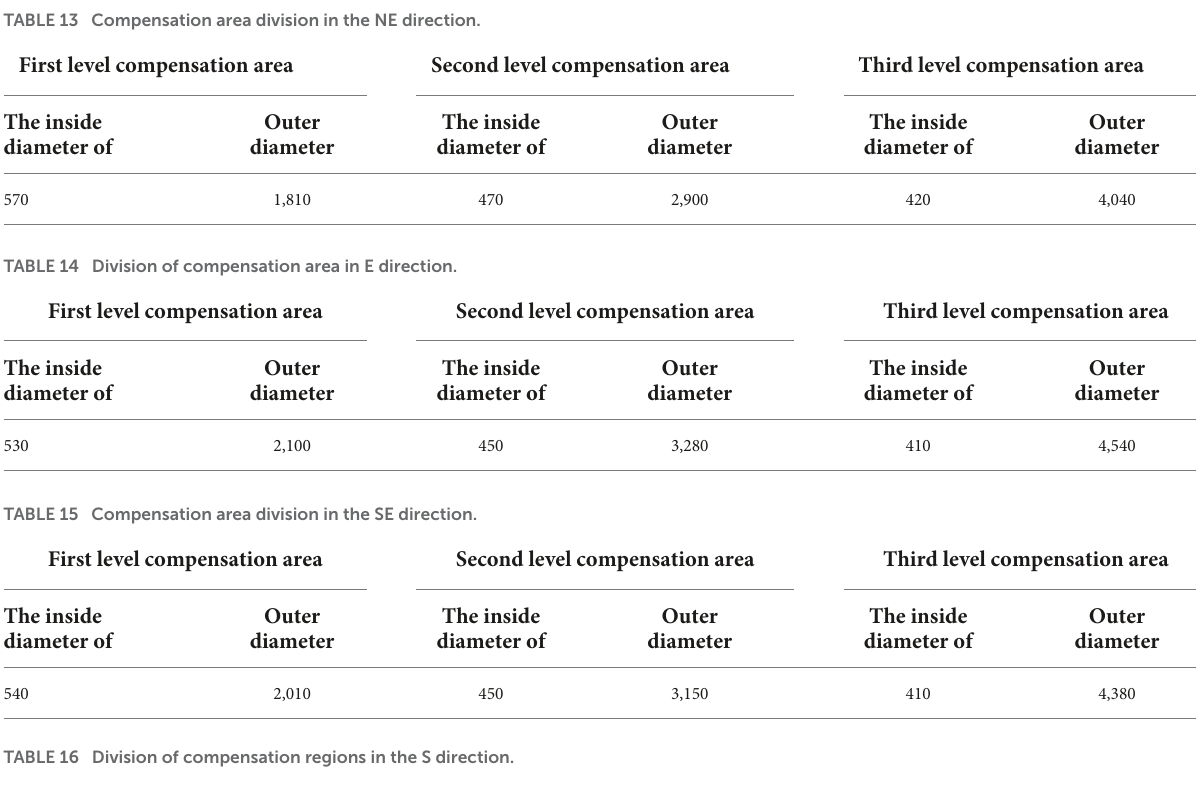
TABLE 13 Compensation area division in the NE direction.